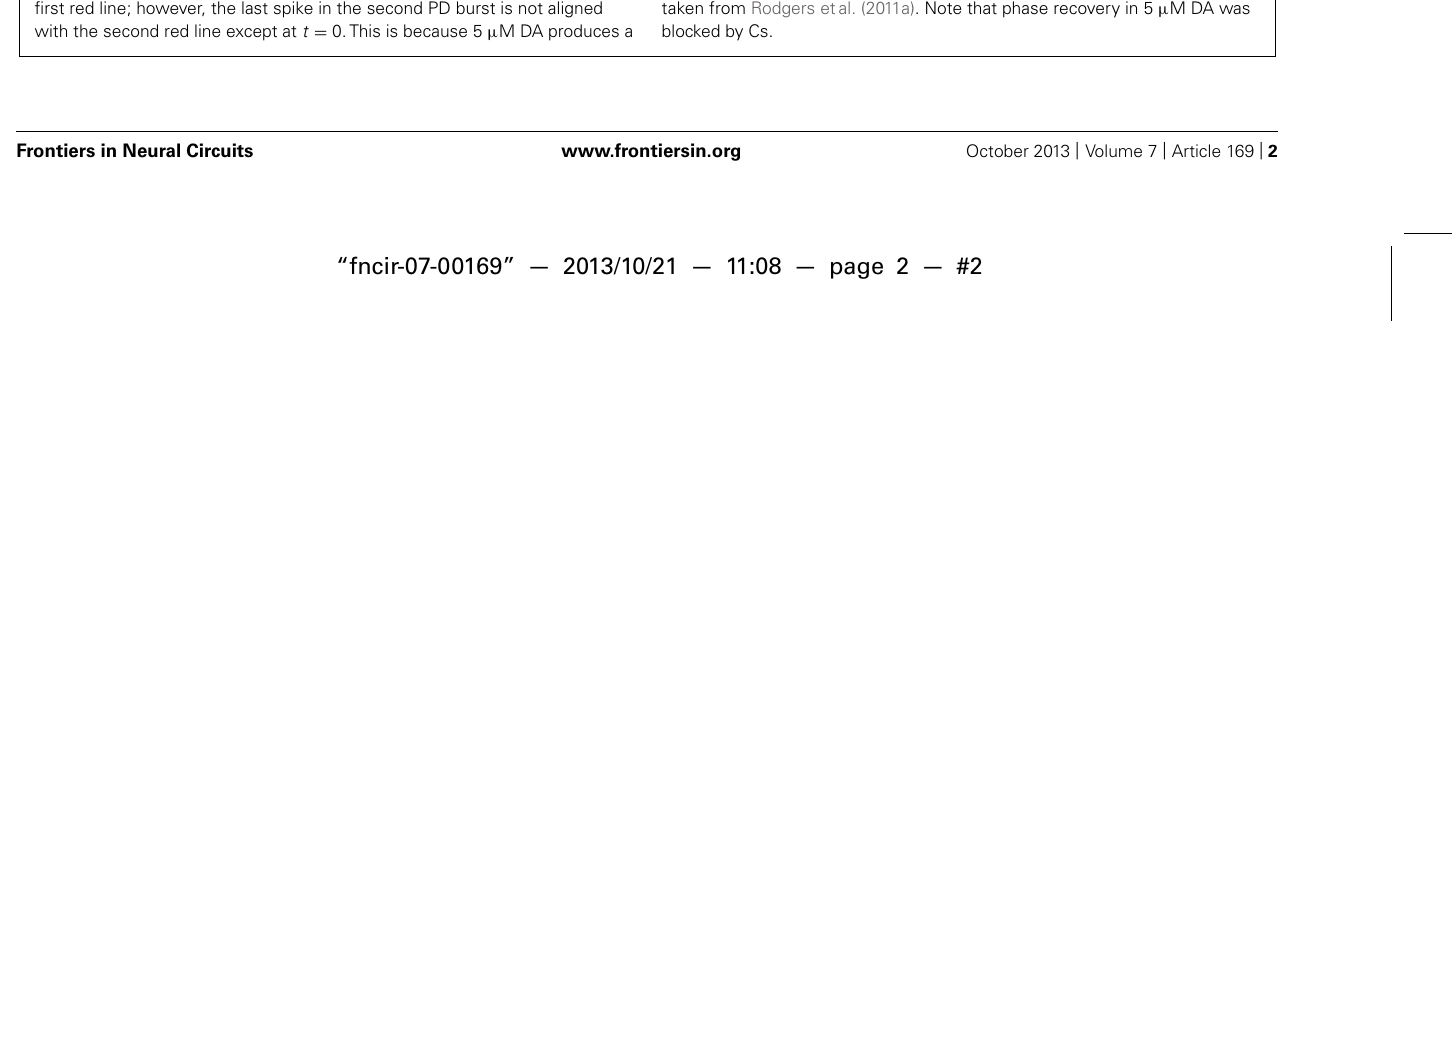
sustained average 10% reduction in cycle period.Thus, for t = 10 and 60 min, the spike in the second PD burst occurs prior to the second red line.Within the indicated cycle, a blue line aligns with the first spike in LP at t = 0.The time between the last spike in PD and the first spike in LP (b) represents LP-on delay, and LP-on phase is: b/a. Note that for the t = 10 min cycle, the first spike in LP occurs well before the blue line.This is because DA produces an average ∼ 20% LP-on phase advance. LP-on phase recovery can be seen in the cycle at t = 60 min because the first LP spike is again aligned with the blue line. Measures of pyloric output parameters can be obtained from either intra- or extra-cellular traces, and LP burst duration is indicated by (c) on the extracellular traces; scale bars: 20 mV and 500 ms. (C) The pyloric circuit: the diagram represents pyloric neuron interactions within the STG. Open circles represent the six cell types, numbers indicate more than one cell within a cell type: anterior burster (AB), inferior cardiac (IC), ventricular dilator (VD); filled circles, inhibitory chemical synapses; resistors and diodes, electrical coupling; red, pacemaker kernel and its output connections. (D) Phase recovery: the preparation shown in (A) was superfused with one of the two indicated treatments for 1 h and LP on-phase was measured every 10 min throughout the experiment ( n ≥ 6/treatment). Average fold-changes in LP on-phase are plotted for each group; yellow asterisks, significantly different from t = 0, data taken from Rodgers etal. (2011a). Note that phase recovery in 5 μ M DA was blocked by